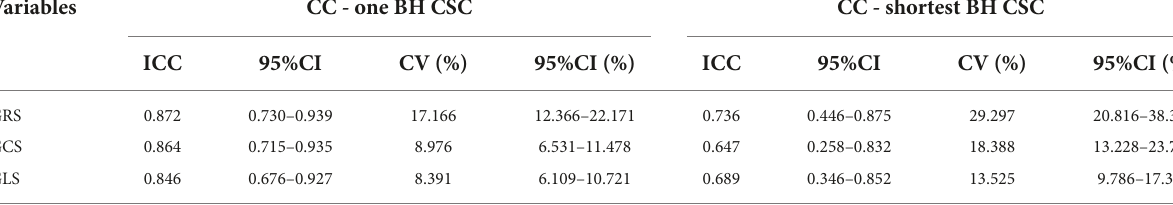
TABLE 3 Agreement of 3D left ventricular global strain assessment between different acquisitions.